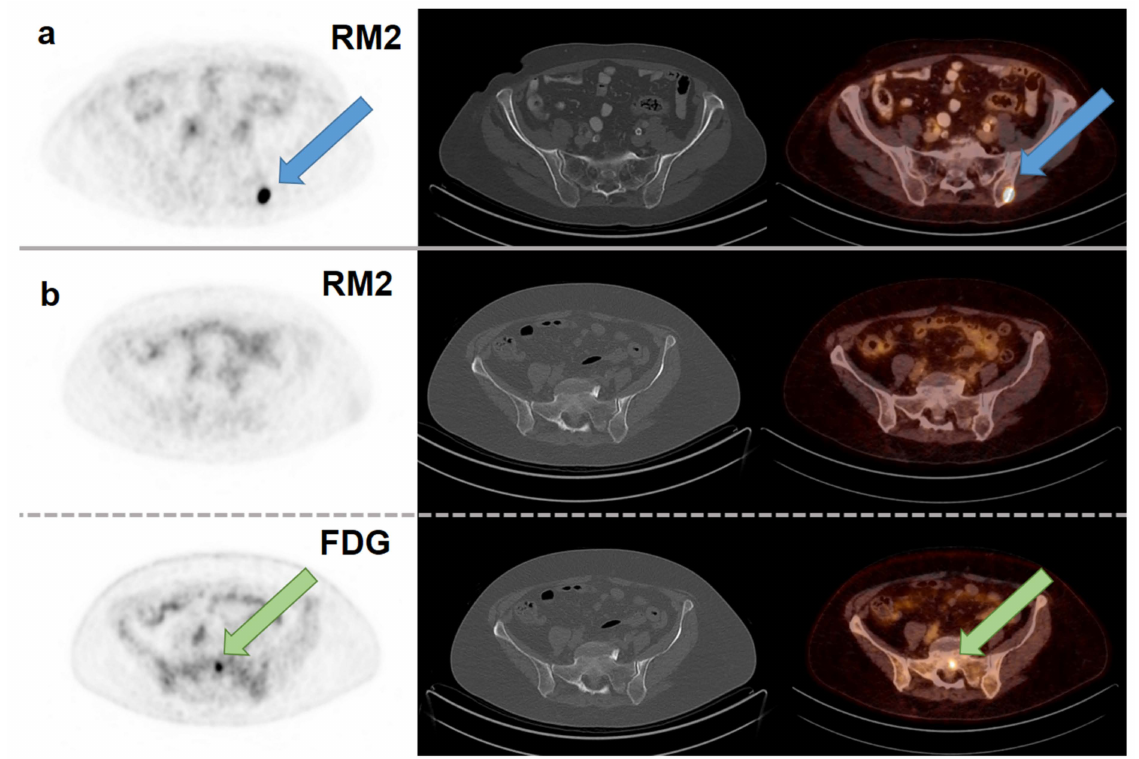
Figure 1. Axial slices of PET scans (first column), CT scans (second column) and fusion images (third column). ( a ) [ 68 Ga]RM2 PET/CT of a 73-year-old patient (patient no. 3) with a bone metastasis in the left iliac bone with intense RM2 binding and not seen on CT (blue arrow; SUVmax 32.1; first row). ( b ) [ 68 Ga]RM2 PET/CT of a 75-year-old patient (patient no. 5) with a bone metastasis in the sacrum without RM2 binding and not seen on CT (SUVmax 1.5; second row). [ 18 F]FDG PET/CT of the same patient with intense hypermetabolism in the sacrum (green arrow; SUVmax 5.8; third row). Note the physiologically higher tracer uptake in healthy bone on [ 18 F]FDG PET. Fixed inversed grey-scale images are displayed with an SUV window of